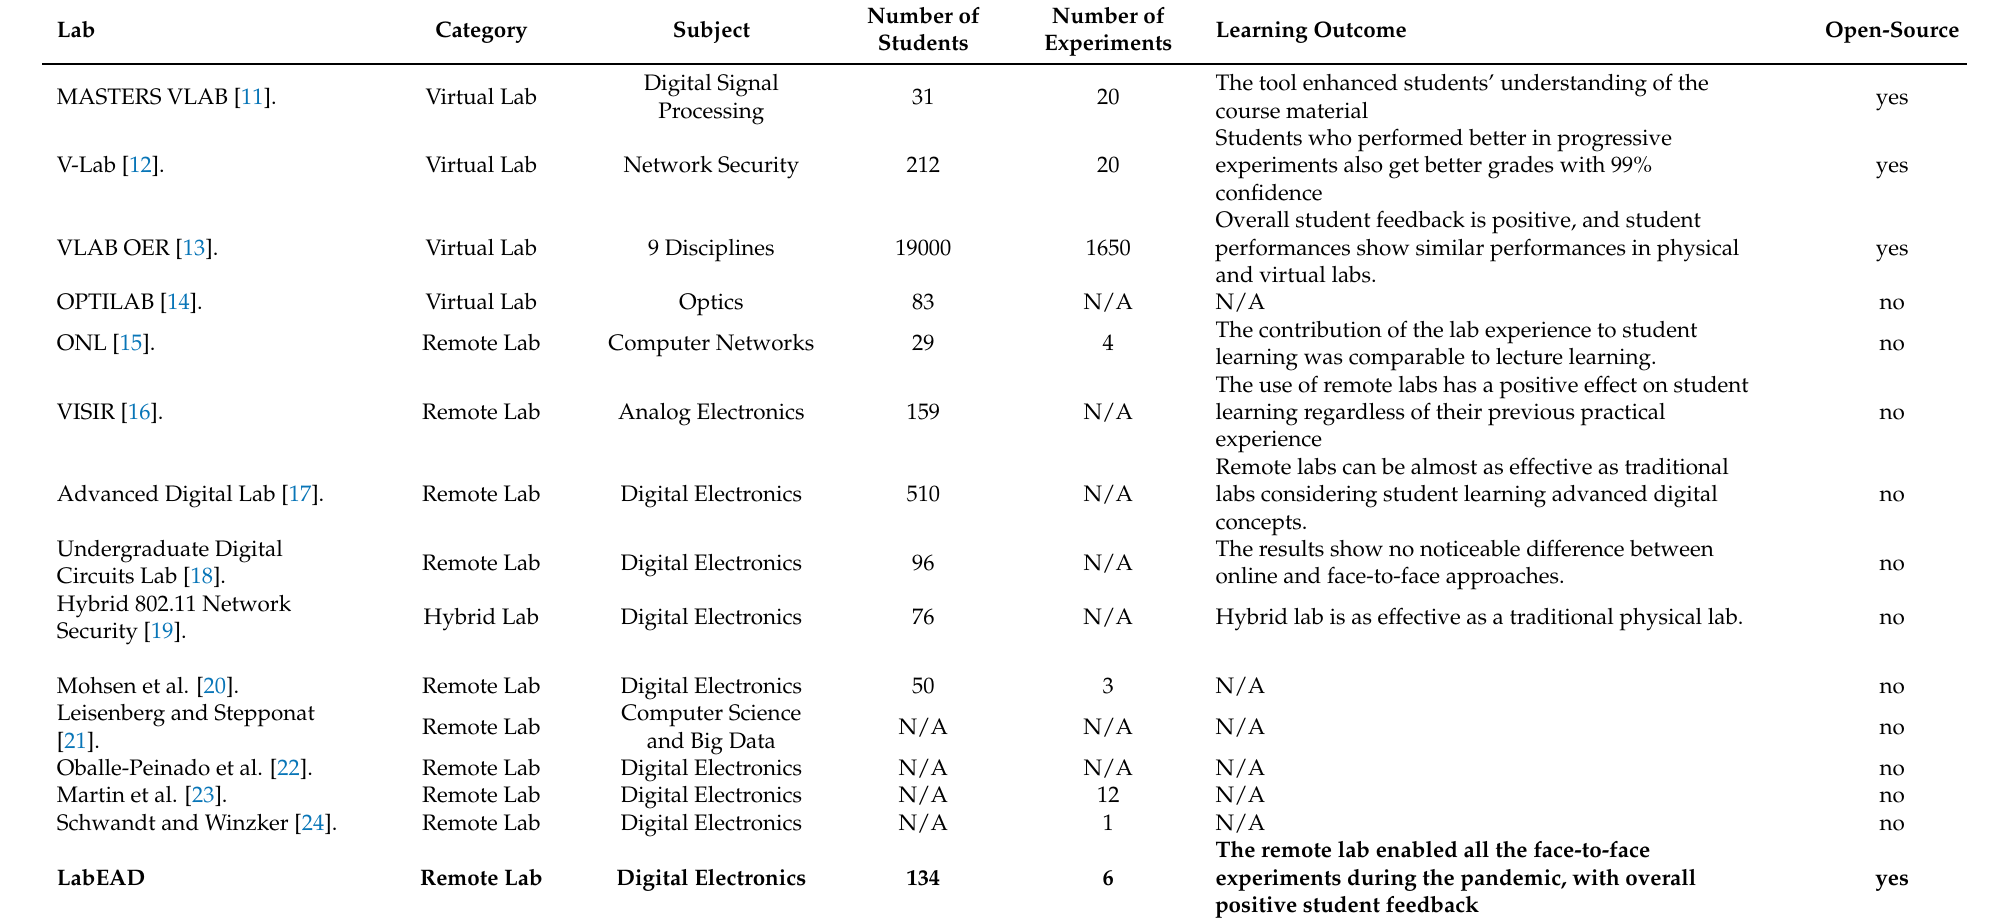
Table 2. Comparison with Related